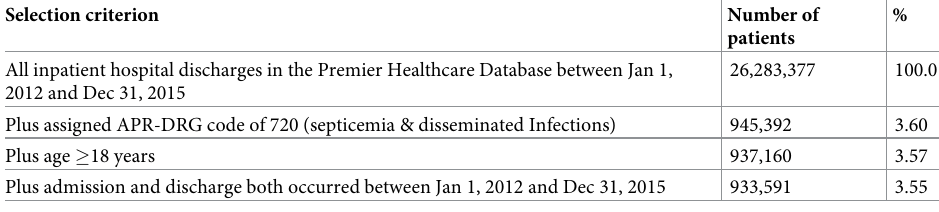
Table 1. Cohort selection from the Premier Healthcare